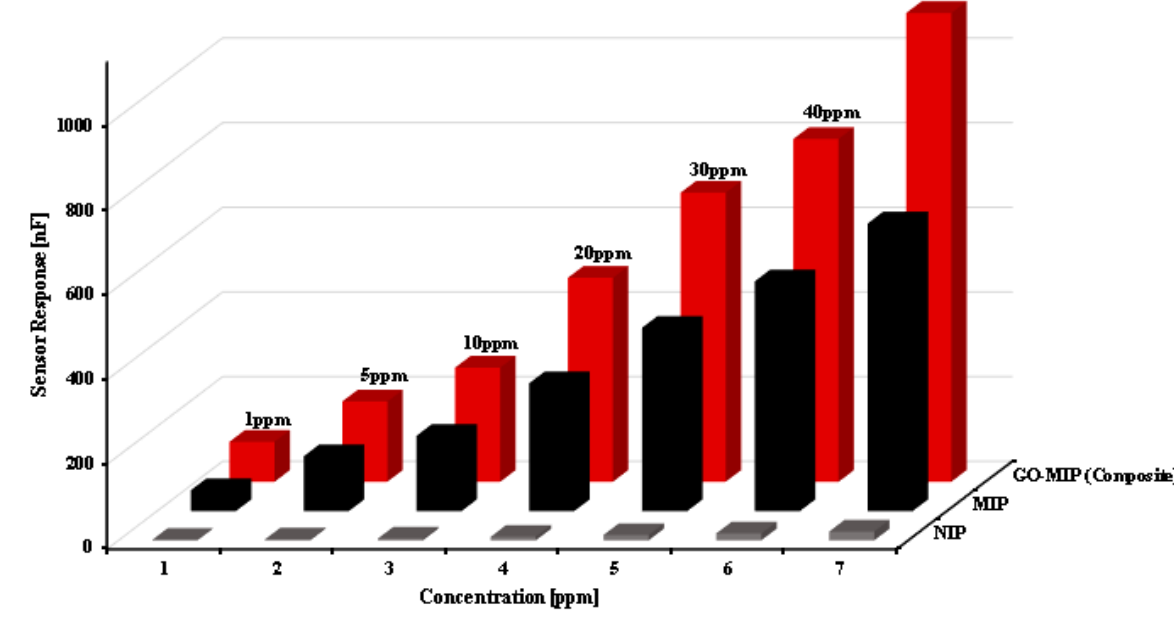
Figure 8. Comparison of sensitivity response of reference, MIP, and GO-MIP nanocomposite.